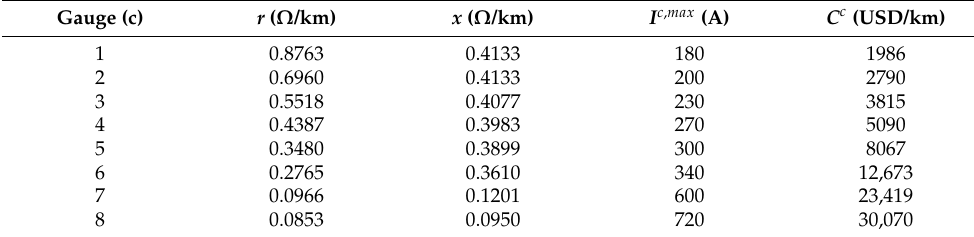
Table 3. Set of conductors for the test systems.